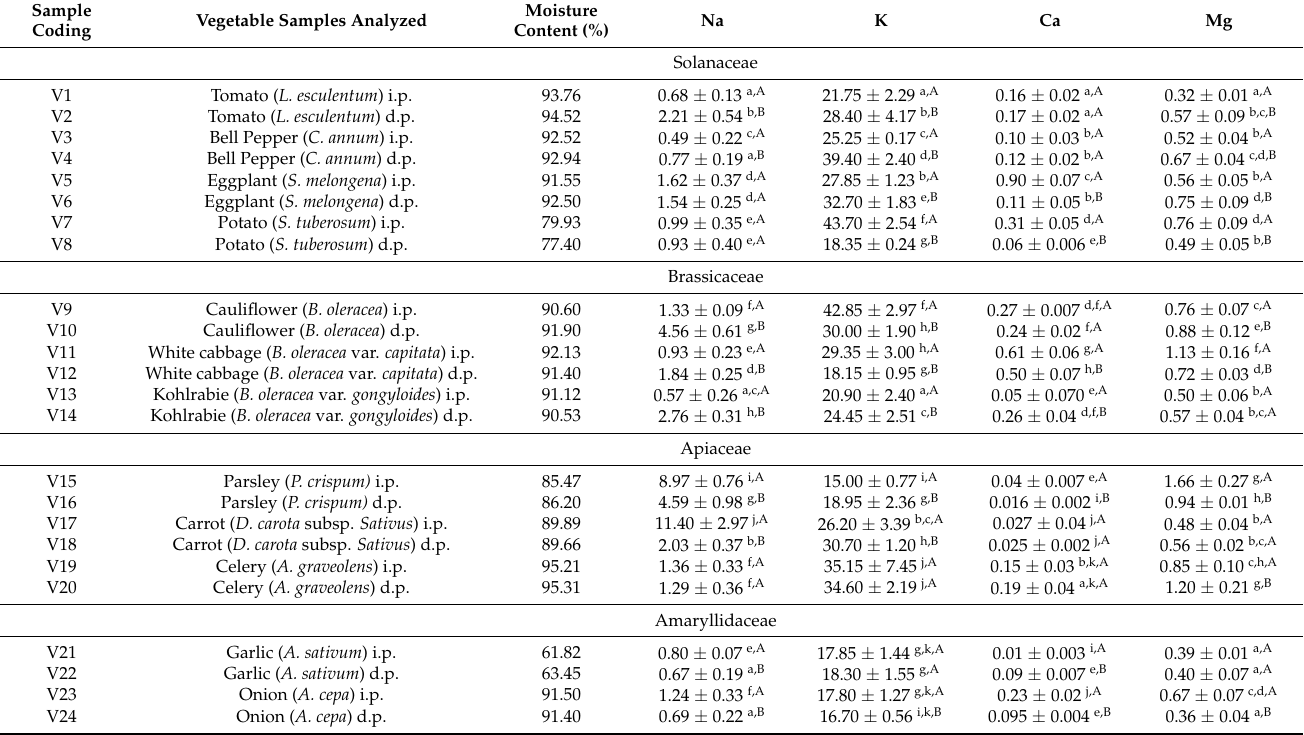
Table 1. The macro elements and moisture content in the 24 vegetable samples of different botanical families (g · Kg − 1 dry weight, mean ±